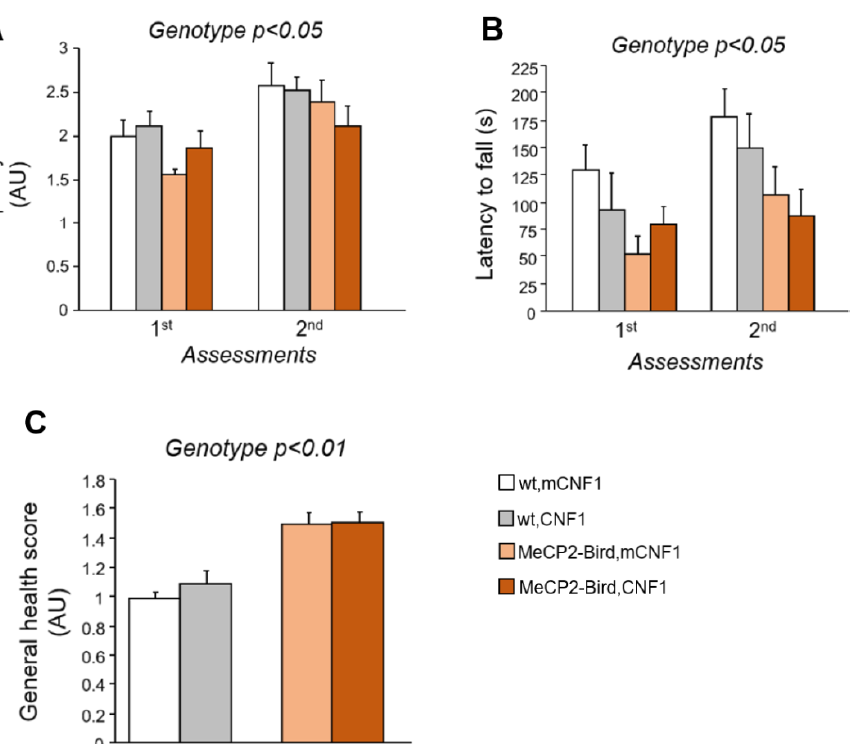
Figure 2. Treatment with CNF1 does not rescue the motor deficits and the impaired general health status of symptomatic MeCP2-Bird female mice. ( A ) Coordinated and purposeful forepaw use was evaluated twice throughout the experimental schedule by the means of the nest building task. Nest quality was assessed by a trained observer blind to mouse genotype and treatment and measured in average units (AU). Symptomatic MeCP2-Bird female mice treated with an inactive form of the bacterial toxin (mCNF1) showed impaired nest building capacity relative to wild type (wt) controls, as demonstrated by the lower nest quality score. CNF1 treatment did not affect their performance. ( B ) Motor learning and coordination was evaluated through the accelerating rotarod task, that was repeated two times during the experiment. Symptomatic MeCP2-Bird females showed reduced motor coordination abilities, as represented by the lower latencies displayed to fall from the rotating rod. The graph represents the average latency out of three consecutive trials/assessment. ( C ) The general health status was evaluated throughout the experimental schedule by a trained observer blind to animals’ genotype and treatment. The average score of the five assessment s is measured in AU and represented in the figure. Symptomatic MeCP2-Bird mice displayed impaired general health conditions compared to wt controls. Treatment with CNF1 was not able to rescue any of these behavioural impairments. Mice for each condition were as follows: wt, mCNF1: 7; wt, CNF1: 7; MeCP2-Bird, mCNF1: 5 – 6; MeCP2-Bird, CNF1: 6. Data are mean ± SEM. Statistical significance was assessed using three-way mixed ANOVA.